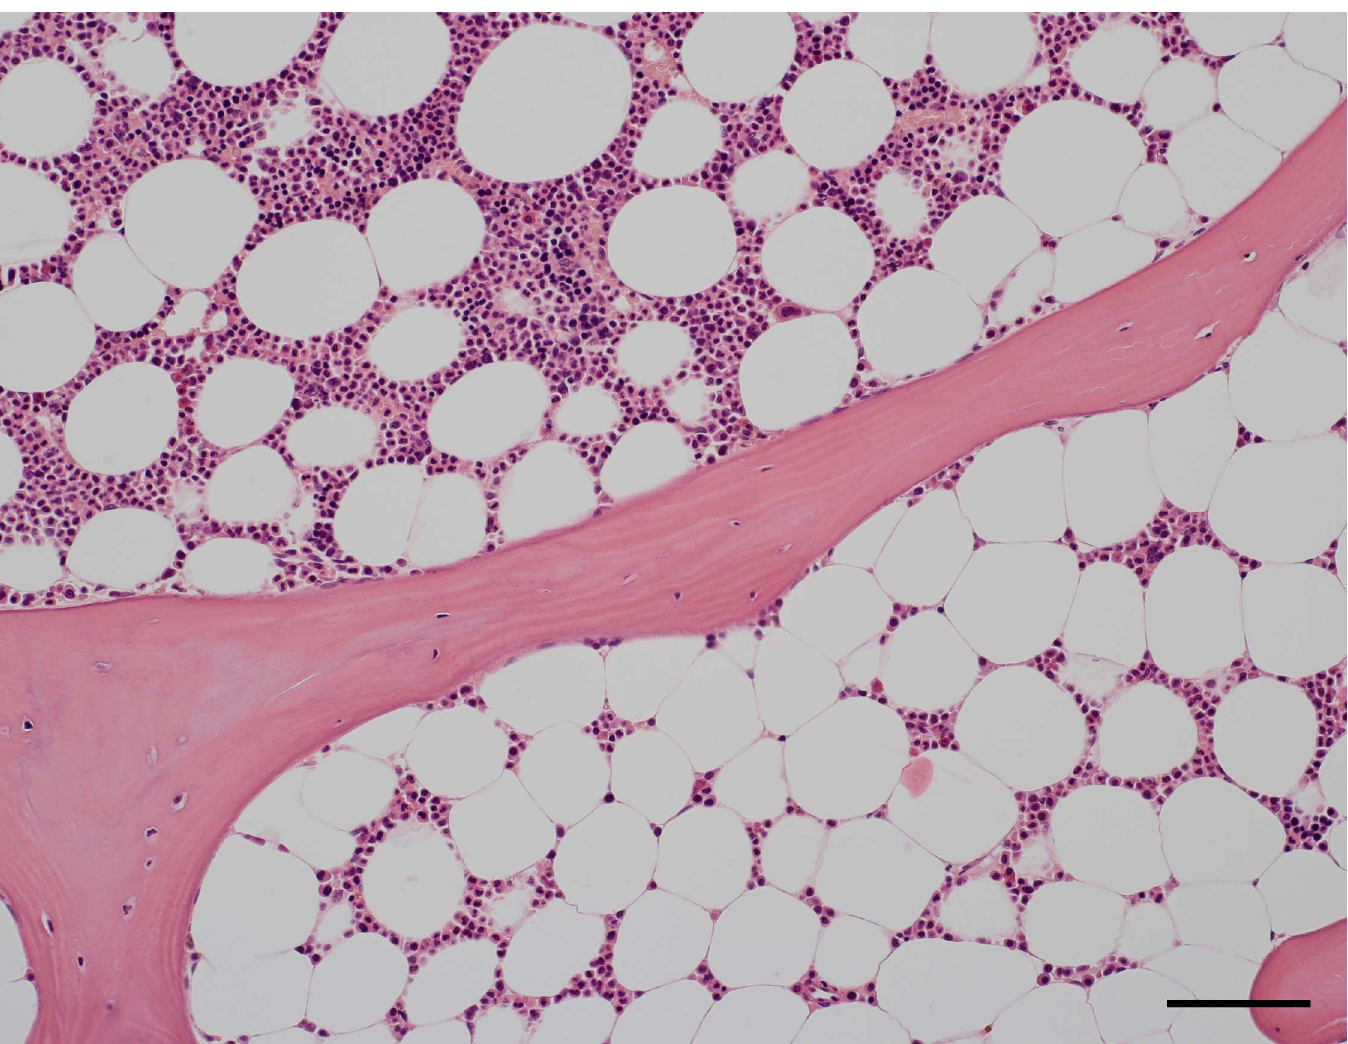
Fig 1. Iliac crest bone marrow stained with hemalum-eosin. Undecalcified section embedded in Technovit ® 9100. The quality of the section is equivalent to a decalcifiedparaffin section. Note the variabledensity of haematopoiesis within directly adjacent adiposetissue areas. Scale bar = 100 μ